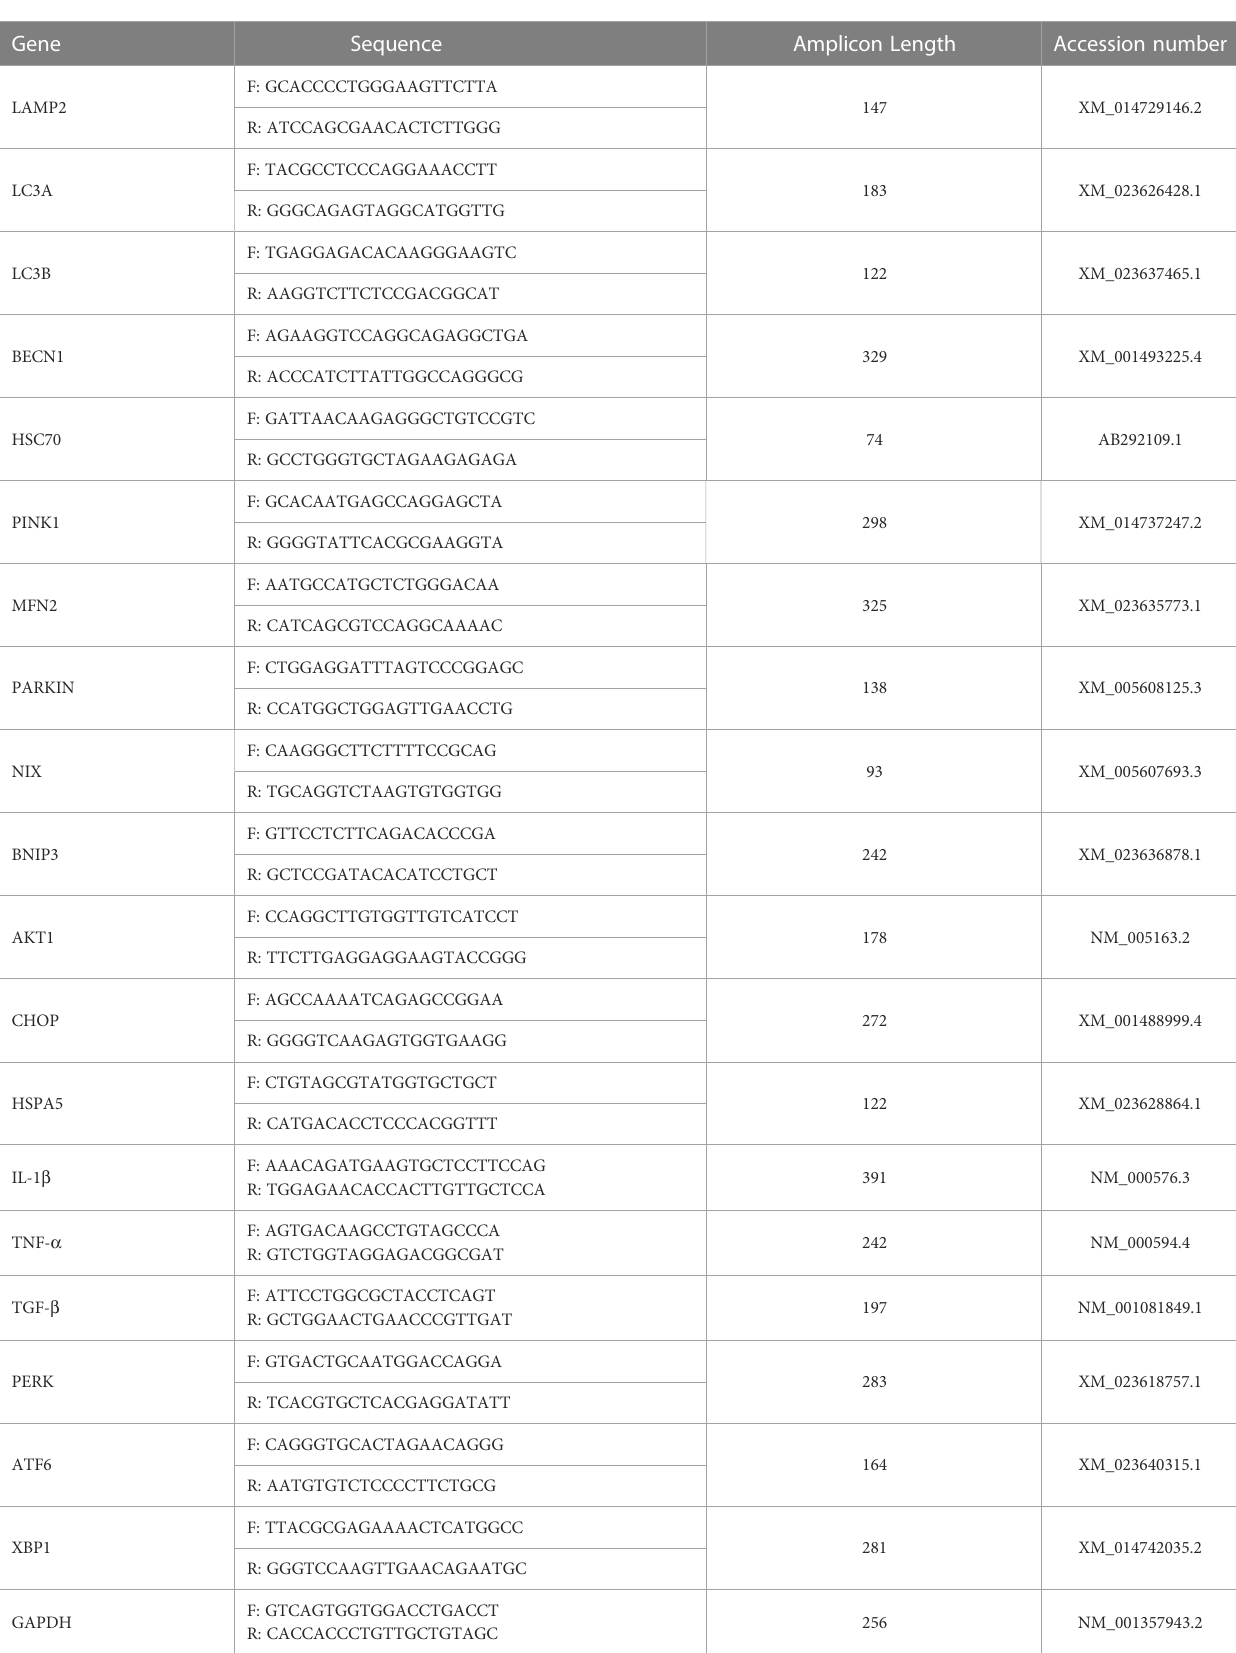
TABLE 2 Sequences of primers used for the RT-qPCR